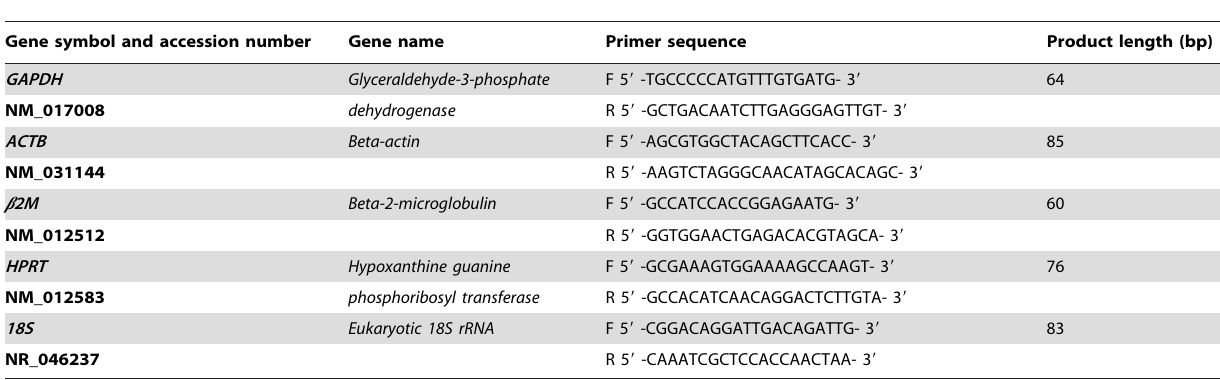
Table 1. Candidate genes, accession numbers and primer sequences.